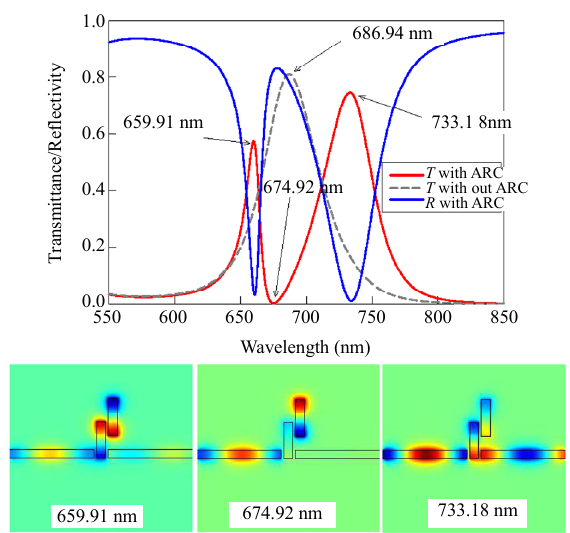
Fig. 2 Transmission and absorption spectra of the dual-rectangular cavity system, the insets show the field distribution of H z at the wavelength of 659.91 nm, 674.92 nm and 733.18 nm, respectively.